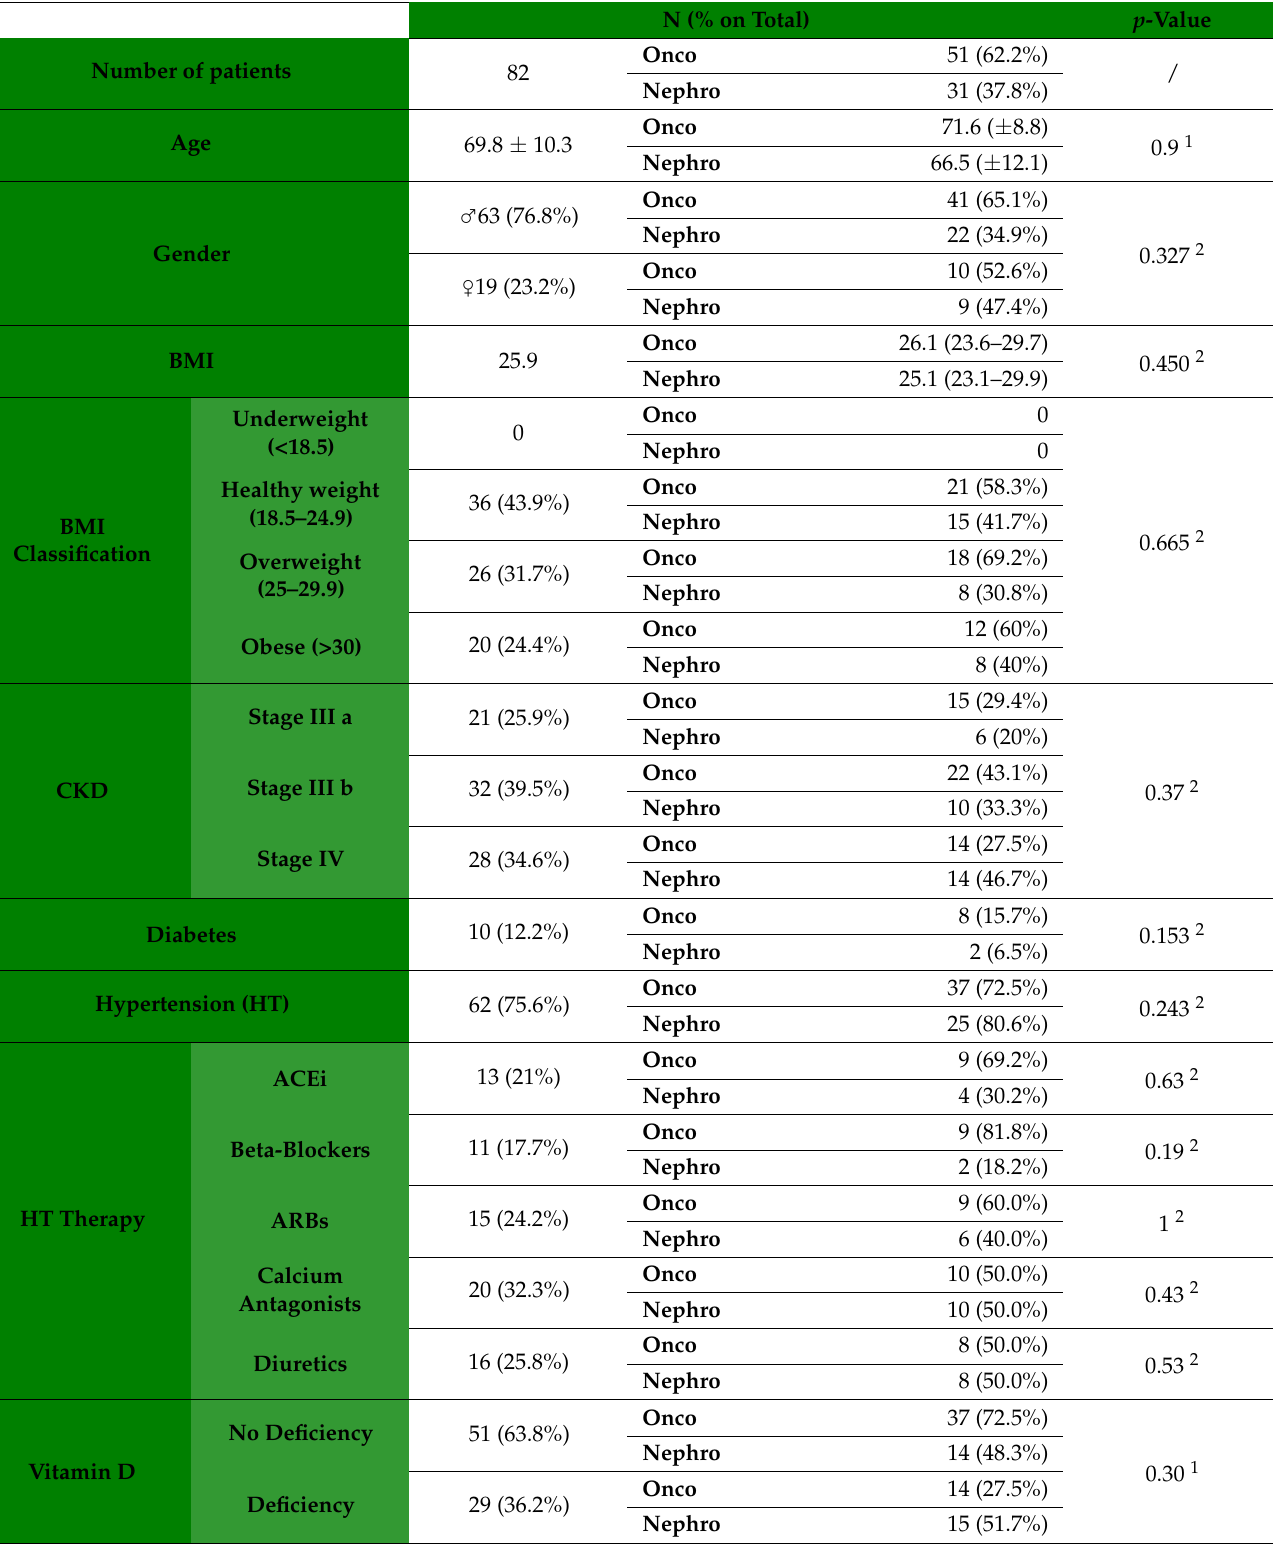
Table 1. Descriptive statistical analysis; 1 shows the p -values obtained through Kruskal–Wallis Rank Sum Test; 2 shows the p -values obtained through Pearson’s Chi-Squared